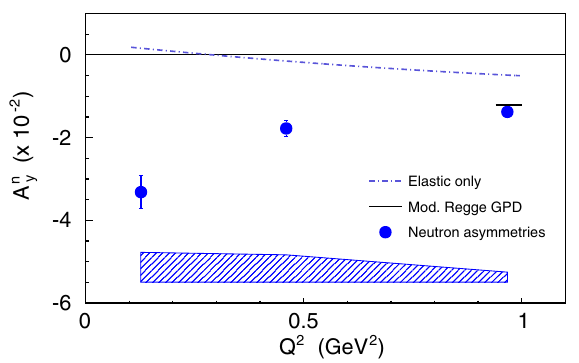
Table 5: Experimental results for A 0 y scaled by 10 − 2 . Figure 5: The target-normal single-spin asymmetry in inclusive 3 He ↑ ( e,e (cid:48) ) . FIG. 4 (color online). Results for the neutron asymmetries, A n y , as a function of Q 2 . Uncertainties shown for the data points are Figure 1: Hall A experimental set-up, where ˆ y is pointed along the statistical. Systematic uncertainties are shown by the band at the vertical direction and ˆ z along the beam. bottom. The elastic contribution to the intermediate state is shown by the dot-dashed line [29], and at Q 2 ¼ 0 . 97 GeV 2 , the GPD calculation of Chen et al. [1] is shown by the short solid line. larger than expected [10]. Another measurement was later